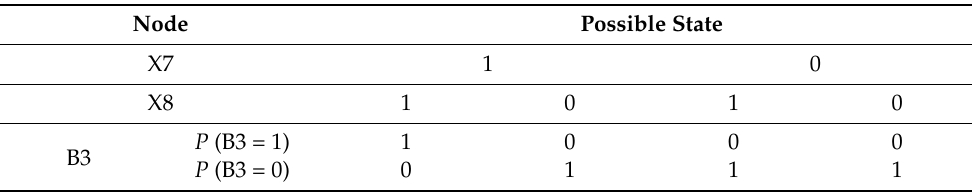
Table 3. Example of “AND gate” conditional probability.